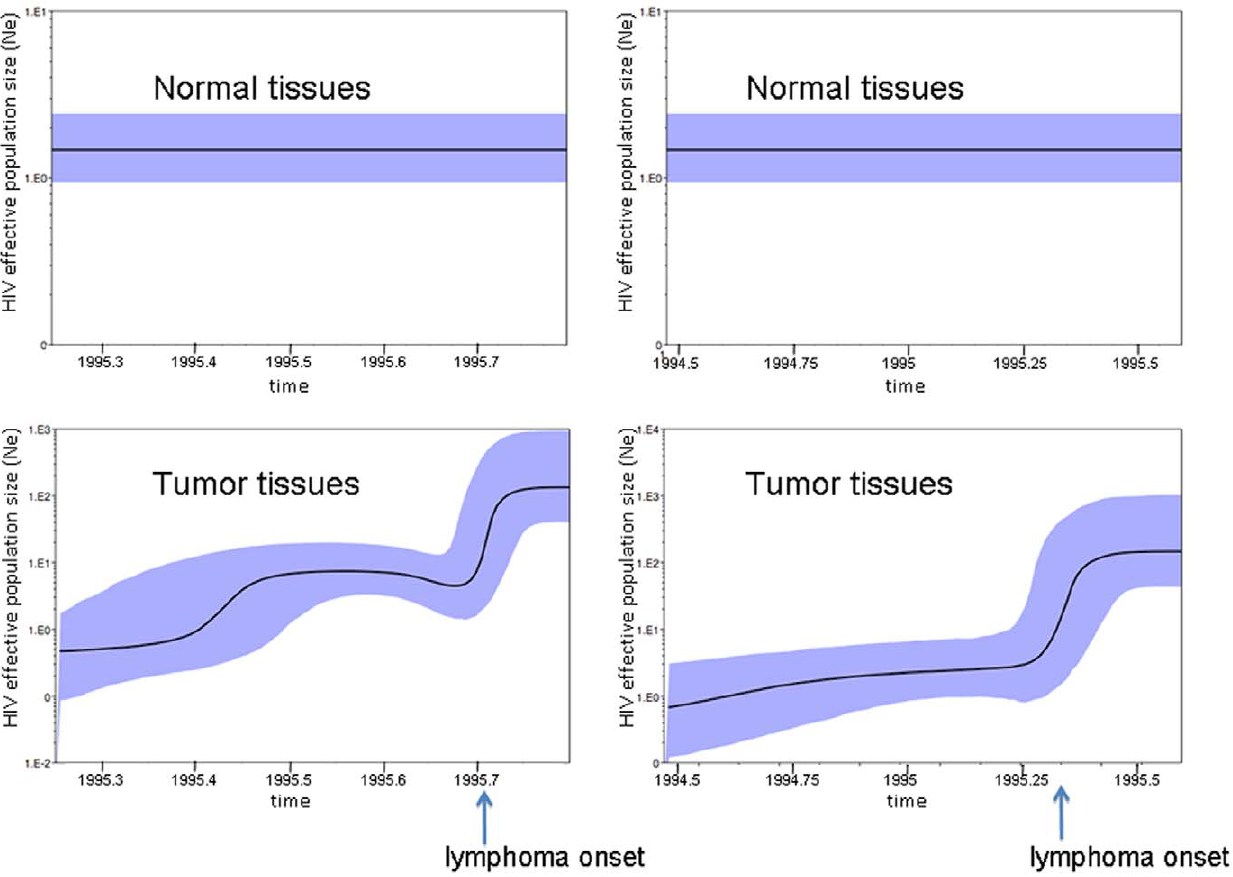
Figure 3. HIV-1 population dynamics in tumor and non-tumor tissues. Bayesian estimates of HIV-1 effective population size (number of infectious genomes effectively contributing to the next generation, y-axis) over time (x-axis) were inferred using the models that fitted best for each data set according to the Bayes Factors test (see Supplemental Table S2). The black line represents the median estimate of the effective population size with the shaded area showing the 95% high posterior density intervals of the estimates. Top panels. Constant population size over time of HIV- 1 in normal tissues from patient AM (left panel) and IV (right panel). Bottom panels. Non-parametric estimates (Bayesian skyline plots) of effective population size change over time for subject AM (left panel) and IV (right panel).